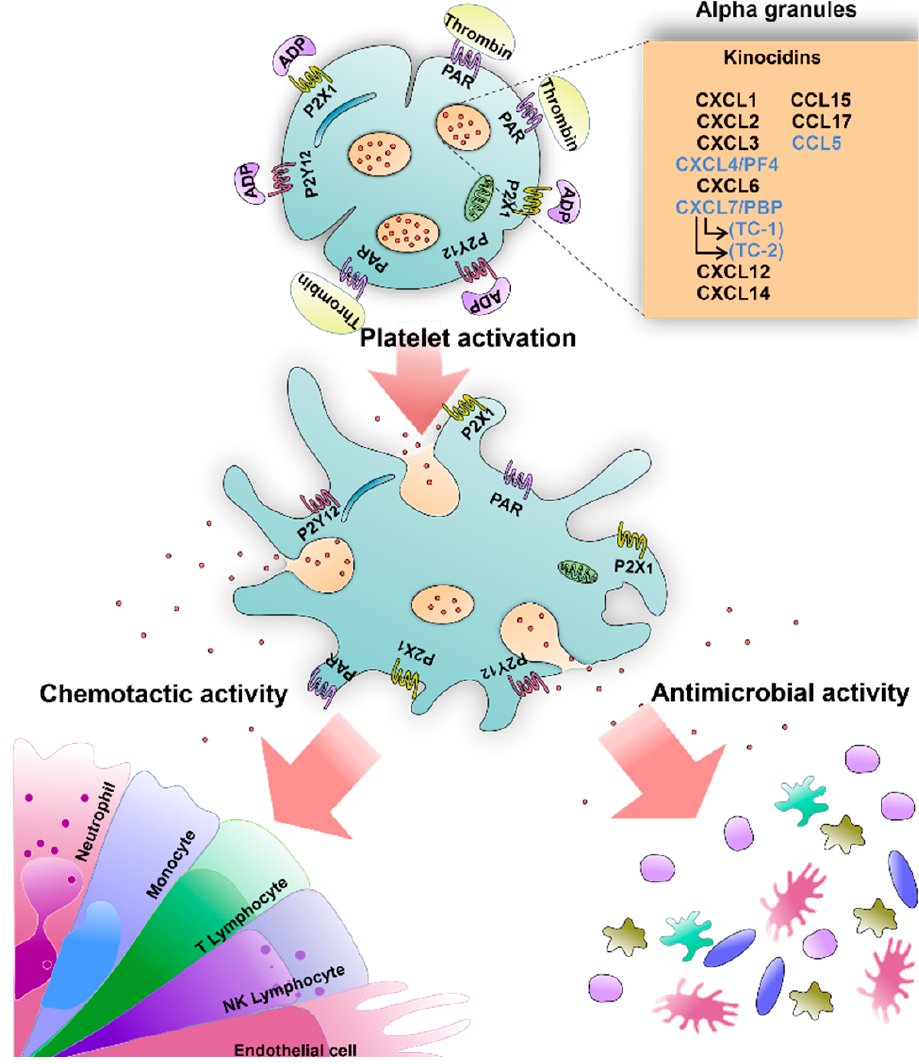
Figure 3. The activity of platelet antimicrobial chemokines/kinocidins. Nonactivated resting platelets store antimicrobial chemokines/kinocidins. Highlighted in blue in the box are those mainly produced by platelets (CXCL-4, CXCL-7, and CCL-5) and their derivatives (TC-1 and TC-2 from CXCL-7). After activation by agonists (ADP and thrombin), platelets release these molecules exerting dual functions, i.e., antimicrobial and chemoattractant for immune